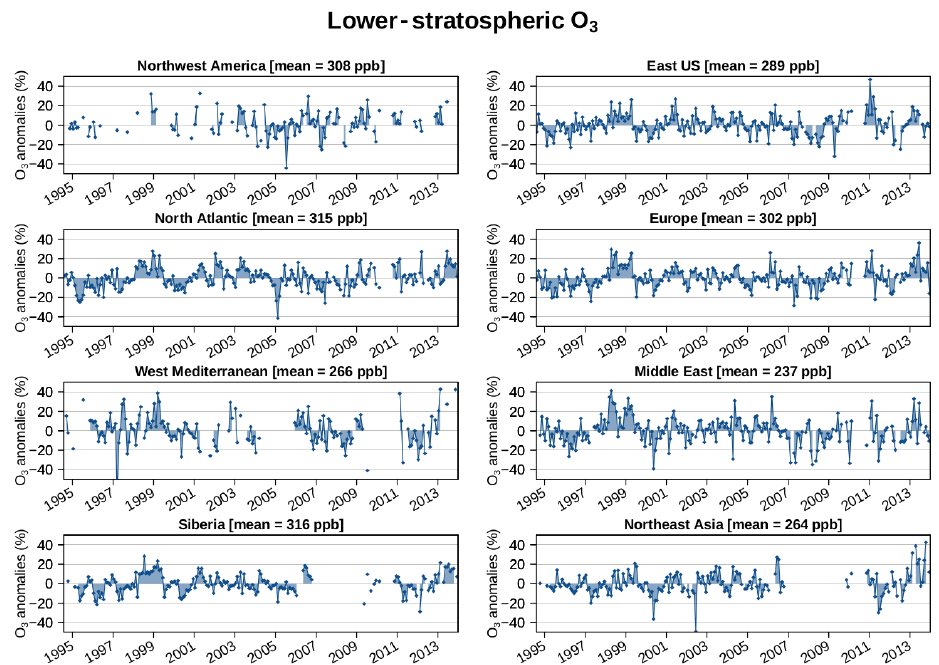
Figure C2. Relative monthly anomalies of O 3 volume mixing ratio in the lower stratosphere. The units % refer to the corresponding clima- tological means indicated above each